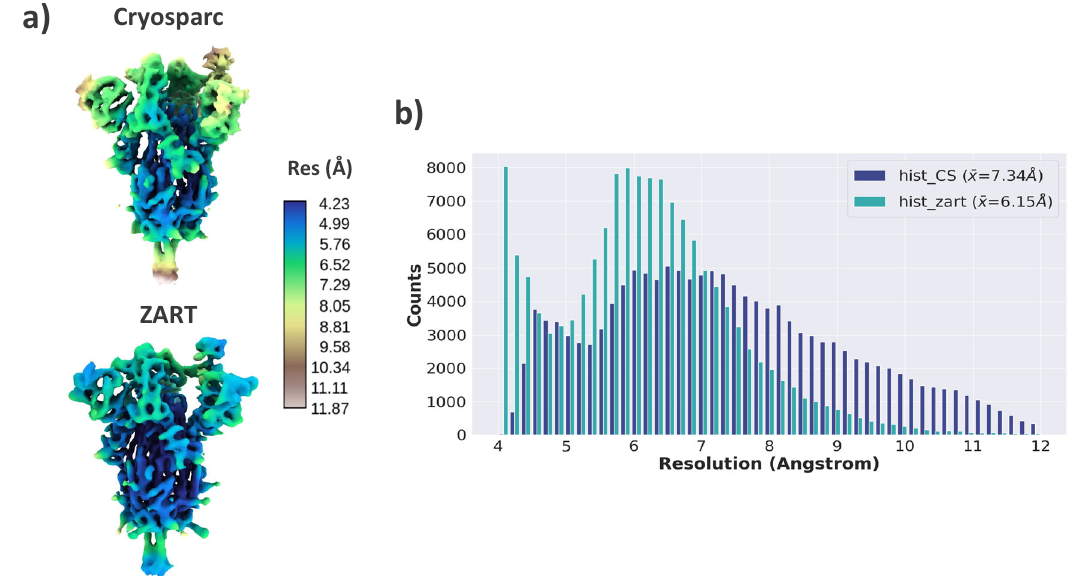
Fig.7|AnalysisofSARS-CoV-2ZARTreconstruction.a ComparisonofSARS-CoV- 2coronavirusspike re fi ned withCryoSparcand themotion-correctedmap recover with our ZART algorithm. The colormap represents the local resolution computed from BlocRes 23 . ZART reconstruction presents a clear improvement in map quality in the RBD, NTDs, and other regions of the spike thanks to the correction of the